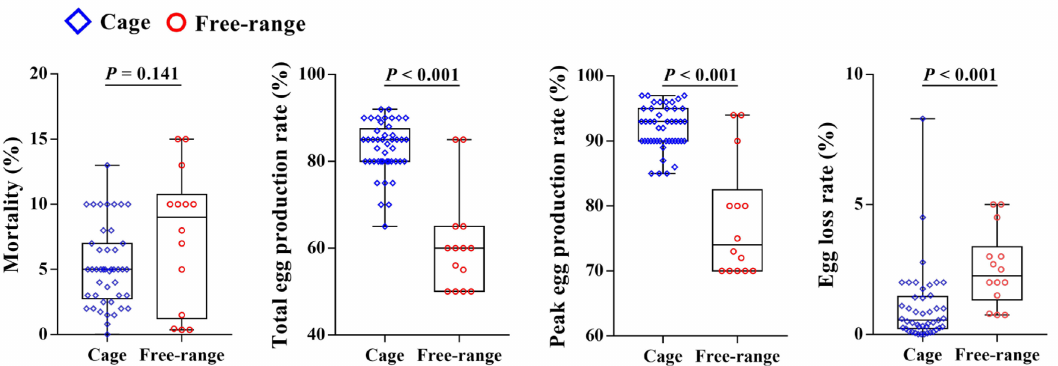
Figure 7. Key production data comparison using a Nonparametric Mann–Whitney U tests in laying hen farms with different feeding modes.